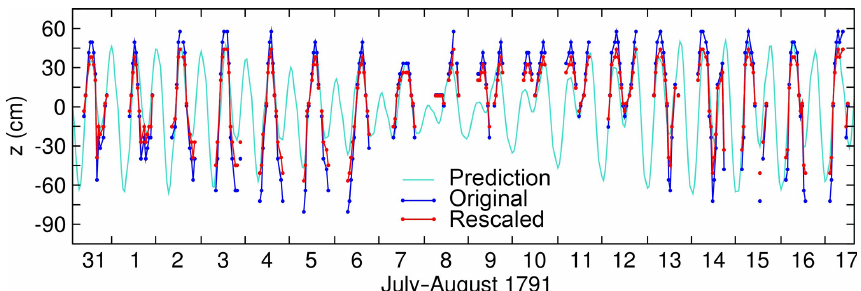
Figure 6. Comparison of original and rescaled sea heights of 31 July–17 August 1791 with tidal prediction. The observed data (original and rescaled) are offset for display purposes by adjusting their respective mean to that of the tidal prediction in the same period.